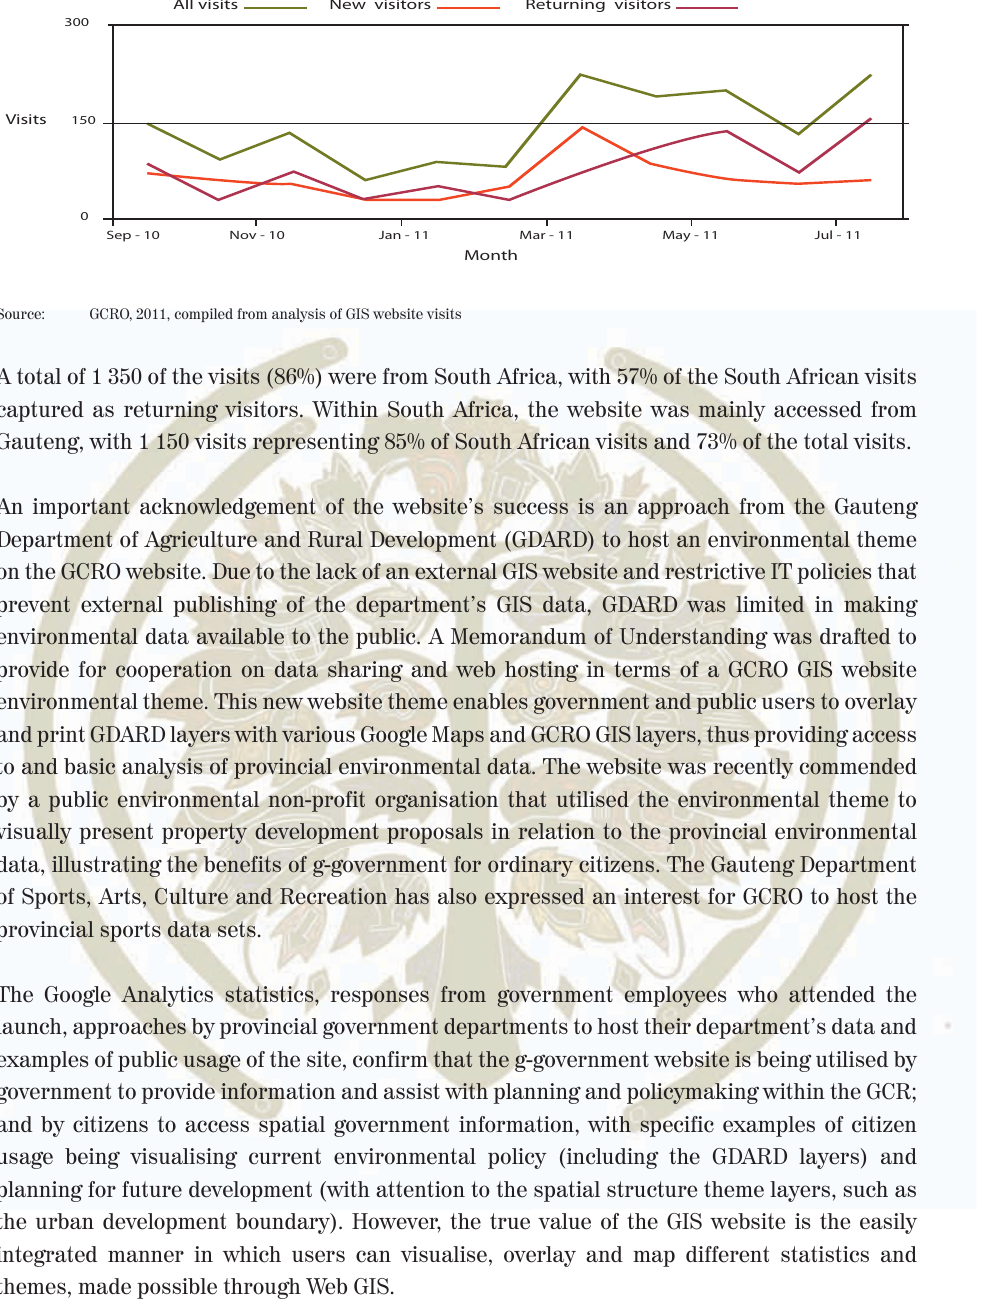
FIGURE 7: GCRO GIS WEBSITE TOTAL NUMBER OF VISITS PER MONTH